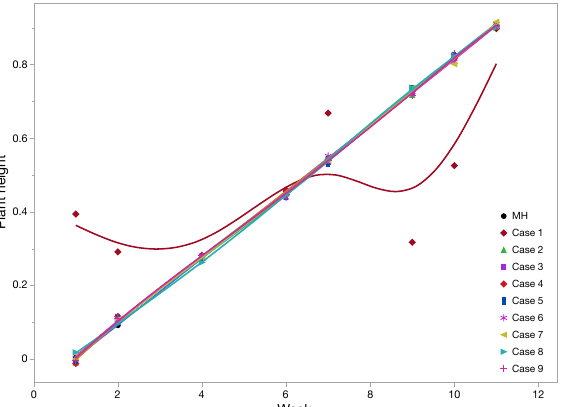
Figure 10. Training: Using the combination of different set of sensors as scenarios (case: Table 2) to analyze its impact on